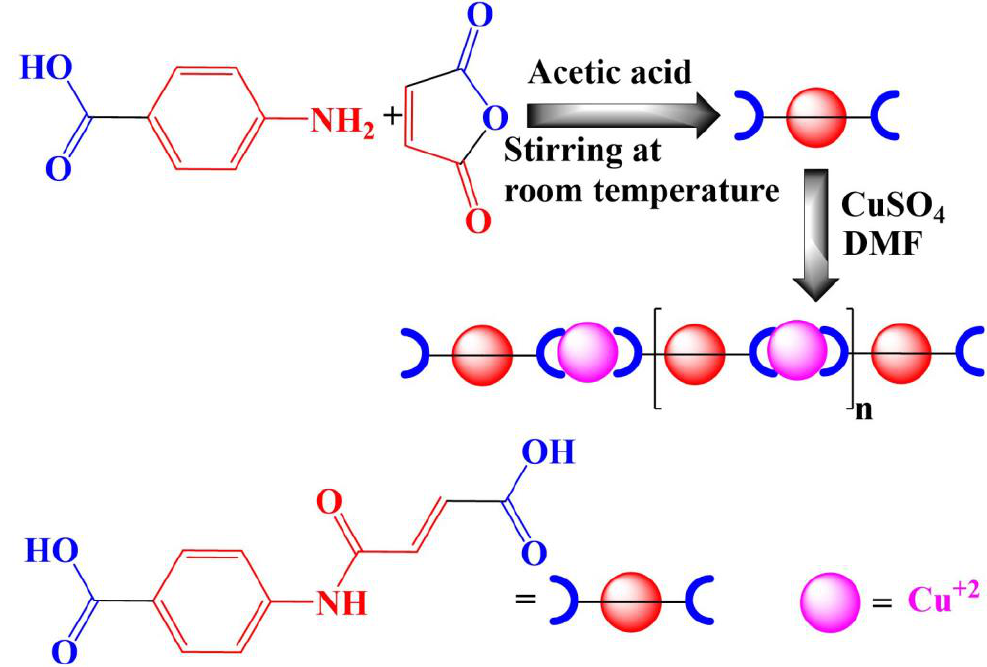
Figure 1. Schematic illustration of Cu(II) synthesis − [ABA − MA] MOF .